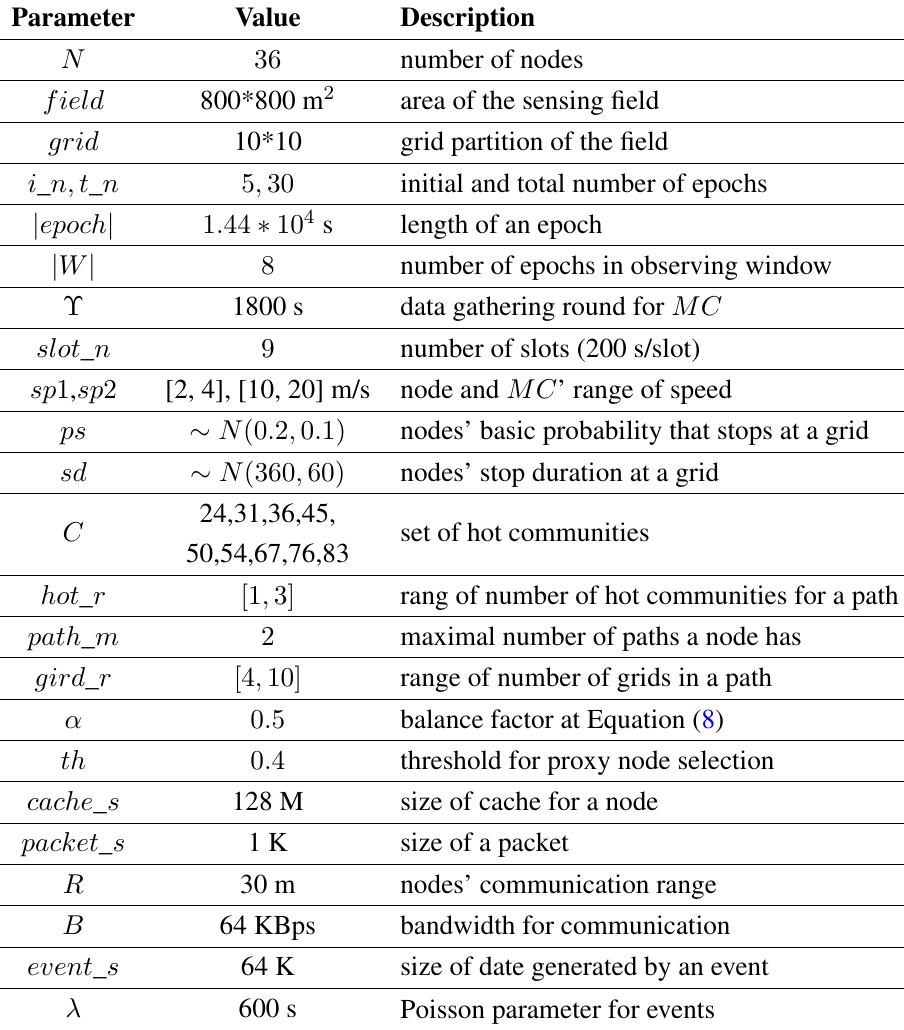
Table 2. Default parameters of the